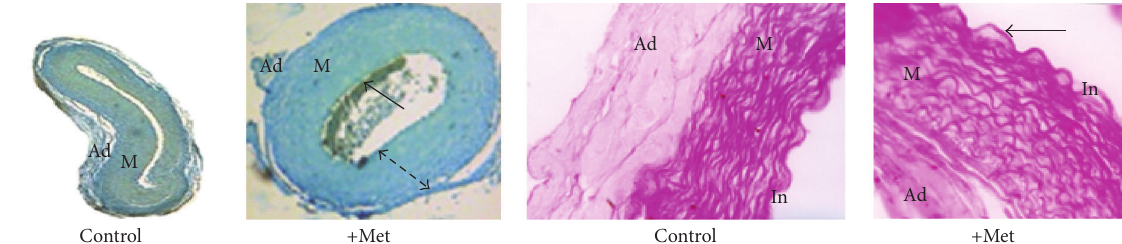
Figure8:Histologyofnewbornrabbitaorta.Picro-Indigo-Carminestaining( × 4magnification)andPASstaining( × 20magnification).Under the effect of Met, the media thickness raises (dashed arrow); the tunica intima becomes apparent with endothelial elevation ( → ).